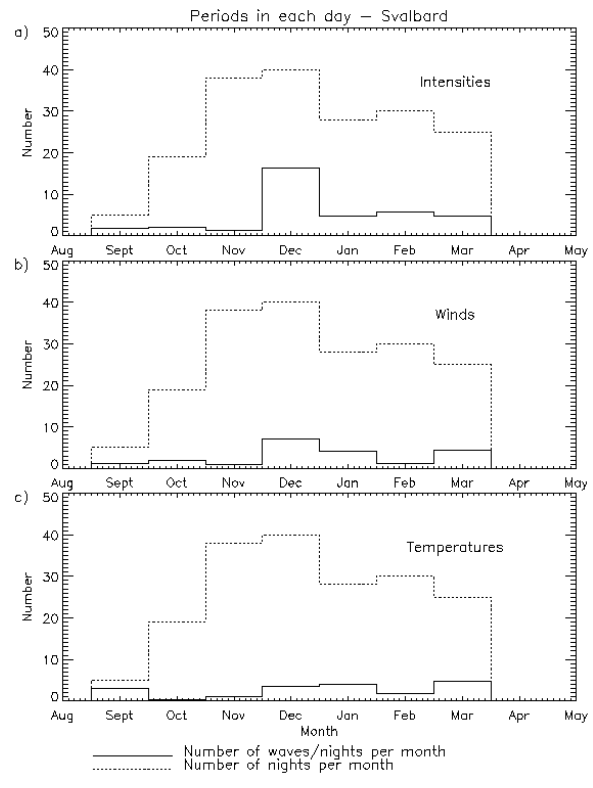
Fig. 17. Number of gravity waves with periods 0–4h detected in each month as a proportion of the number nights of data, for all Svalbard data (2000–2006): (a) intensities, (b) winds, and (c) tem-